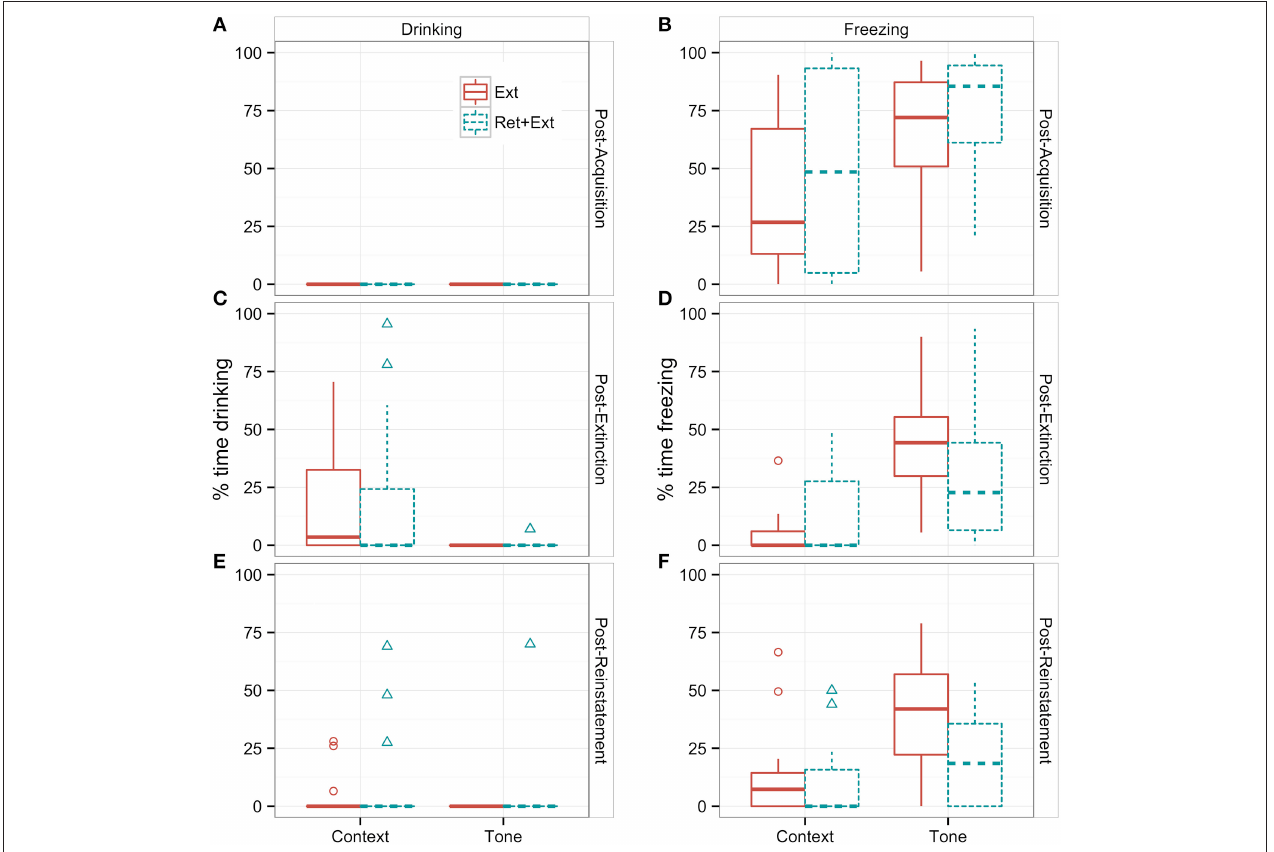
FIGURE 4 | Tests of fear vs. extinction memory as indicated by percent time drinking (A,C,E) and percent time freezing (B,D,F) measured during pre-CS (Context) vs. CS (Tone) during the first post-acquisition trial (A,B), post-extinction trial (C,D), and post-reinstatement trial (E,F). Data are presented as boxplots to demonstrate their range and distribution, which differ markedly between drinking vs. freezing and between tone vs. context. Boxes represent the middle 50% of the distribution (the interquartile range between the 25th and 75th percentiles), and the horizontal line indicates the median. The “whiskers” that extend vertically from the box indicate the range of observations that fall within ± 1.5 times the interquartile range, and any observations outside the whiskers are graphed as individual points. Note the complete suppression of drinking (A) vs. the large variability in freezing (B) following fear conditioning. A significant mean difference between Ext vs. Ret + Ext groups was only observed for tone-CS freezing following reinstatement (F)